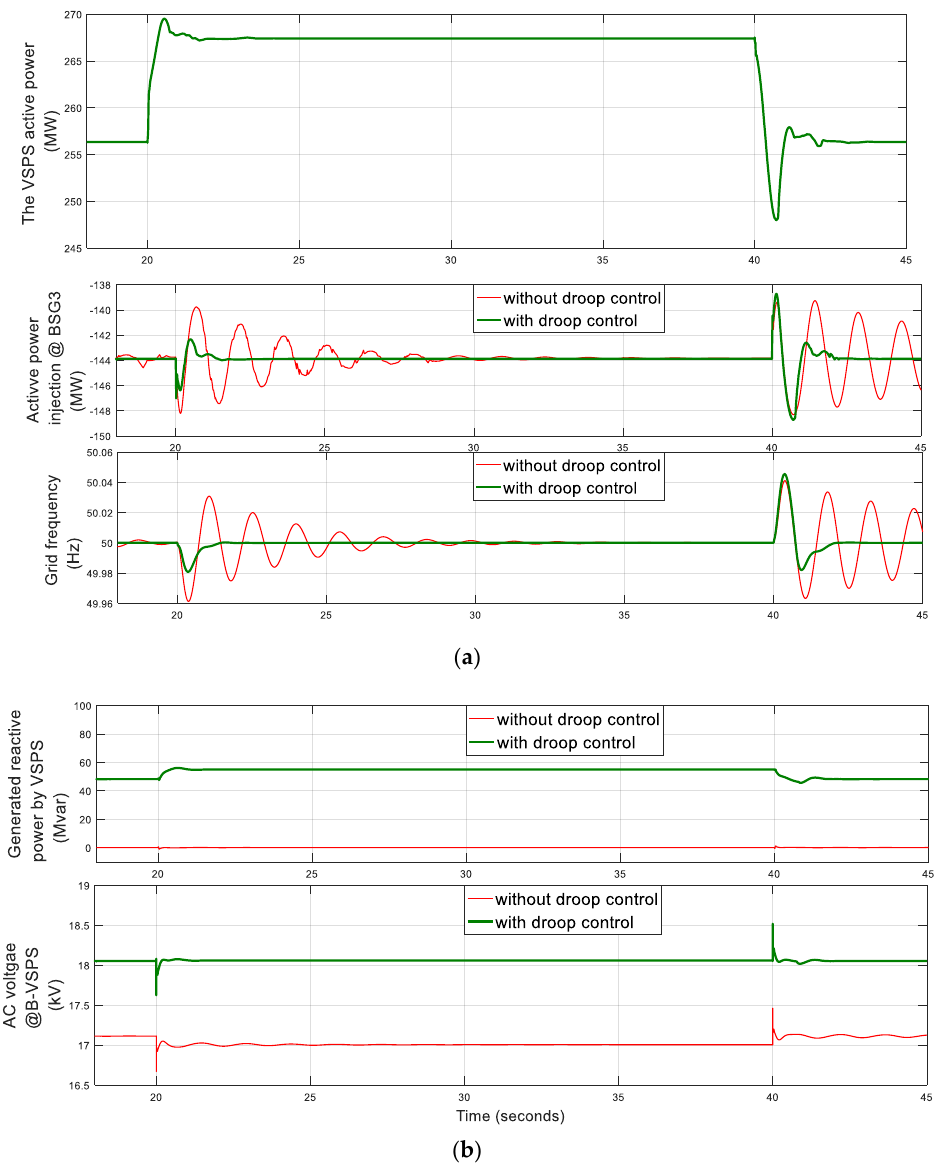
Figure 16. Evolutions of the network in the load variations; ( a ) in frequency control and response associated with active power; ( b ) AC bus voltage control and response associated with reactive power generation by the VSPS.